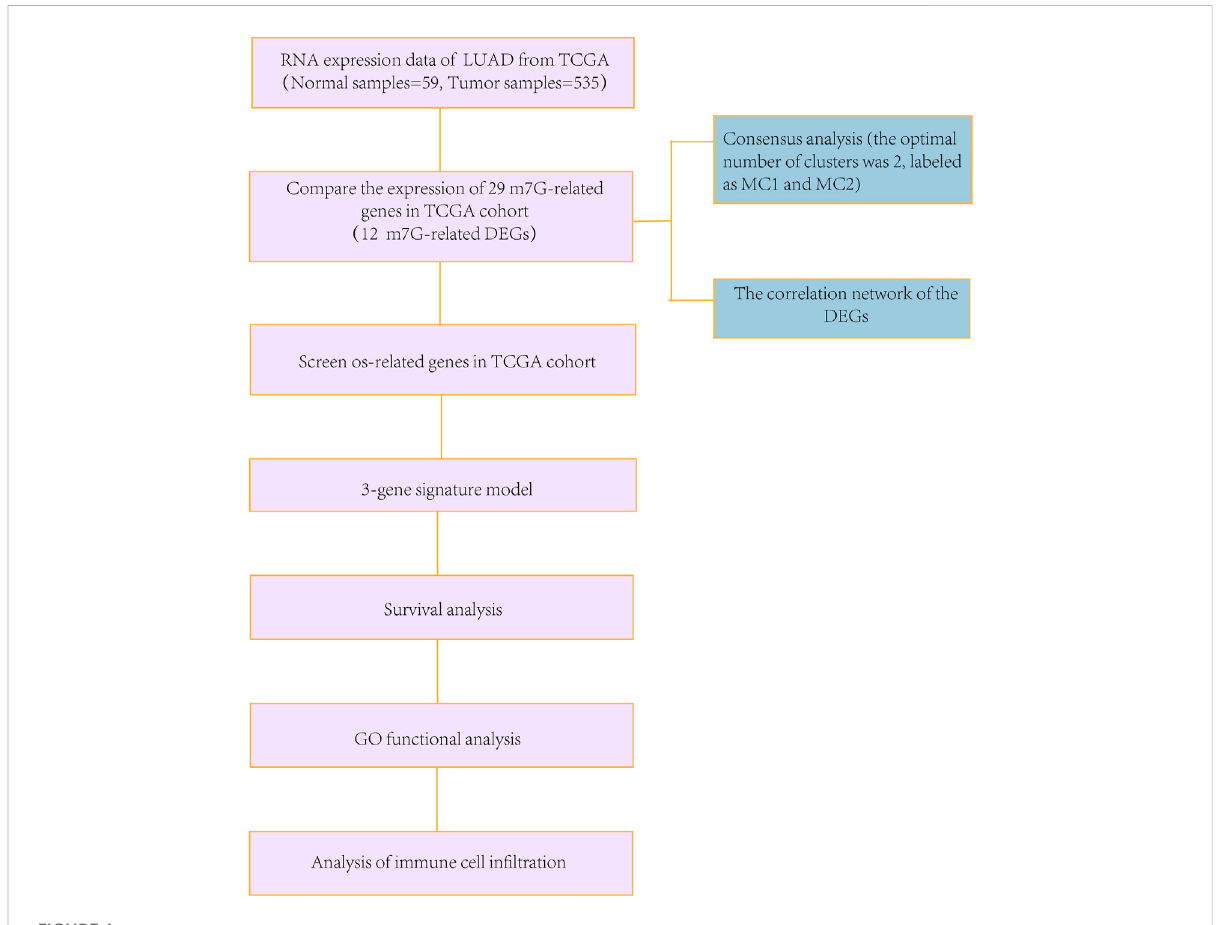
FIGURE 1 Detailed work fl ow of the fl owchart for data